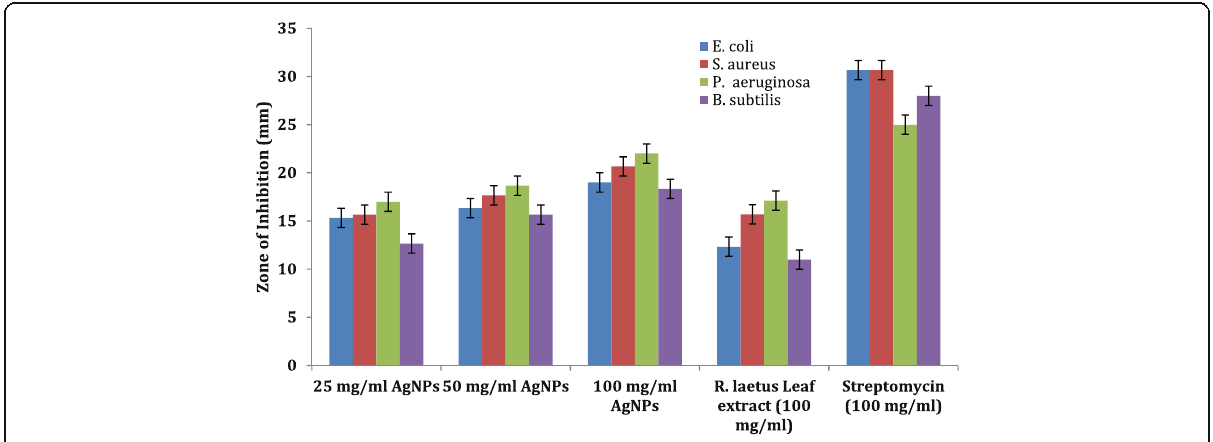
Fig. 6 Antibacterial activity of R. laetus -mediated AgNPs and R. laetus leaf